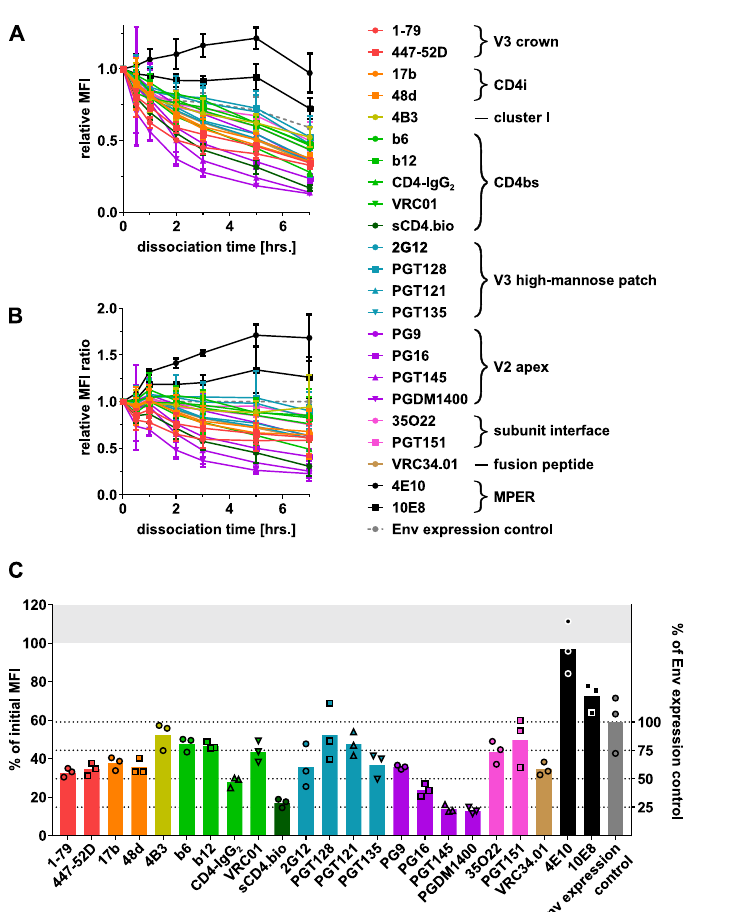
Fig 6. Dissociation of inhibitors from the cell surface–expressed, CD4-unbound BaL.01 SOS Env. BaL.01 SOS Env–expressing HEK 293T cells were stained with 5 μ M biotinylated sCD4 or 10 μ g/ml of other HIV-1 inhibitors that were then allowed to dissociate at 37 ˚C until the cells were chemically fixed. The amount of bound inhibitor remaining at the time of fixing was quantified by flow cytometry. Dead cells were excluded from analysis, and background signal from MuLV Env–expressing control cells was subtracted. A separate aliquot of cells stained with 10 μ g/ml of 2G12 mAb only after fixing served as an “Env expression control” for the total amount of Env present on the cells at each dissociation time point. (A) MFI values for each inhibitor and Env expression control were normalized to the dissociation time t = 0 (mean [SD] of three independent experiments). (B) The resulting relative MFI values for each inhibitor were divided by the relative MFI value of the Env expression control for the respective time point (mean [SD] of three independent experiments). (C) Relative MFI values for each inhibitor and Env expression control at dissociation time t = 7 hours. Bars indicate the respective means of three replicate values depicted by symbols. Underlying flow cytometry data are depicted in S13 Fig. CD4bs, CD4 binding site; CD4i, CD4-induced site; Env, envelope glycoprotein; HEK, human embryonic kidney; HIV-1, human immunodeficiency virus type 1; mAb, monoclonal antibody; MFI, mean of fluorescence intensity; MPER, membrane-proximal external region; MuLV, murine leukemia virus; sCD4, soluble CD4; V2, second hypervariable; V3, third hypervariable.